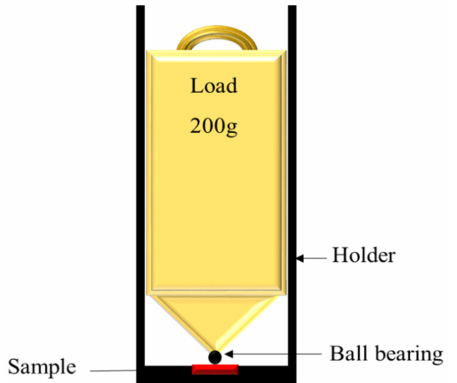
Figure 2. Schematic diagram of micro-indentation test